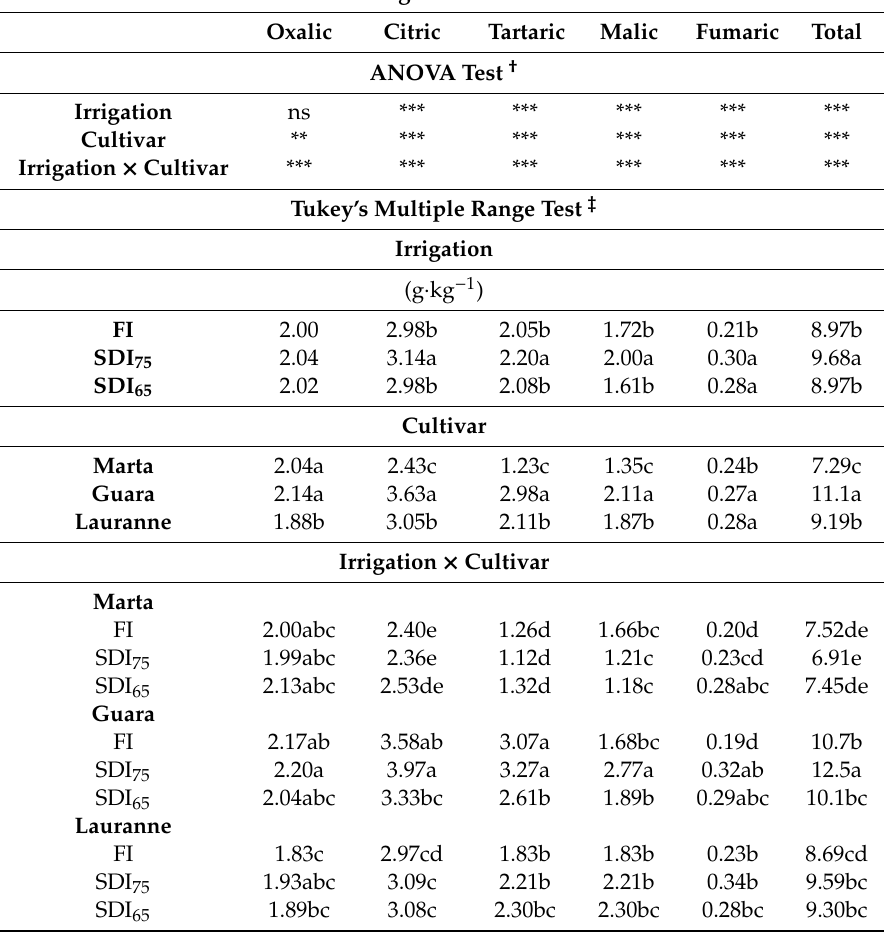
Table 4. Organic acids in raw almonds as a ff ected by irrigation dose and cultivar. Organic Acids Oxalic Citric Tartaric Malic Fumaric